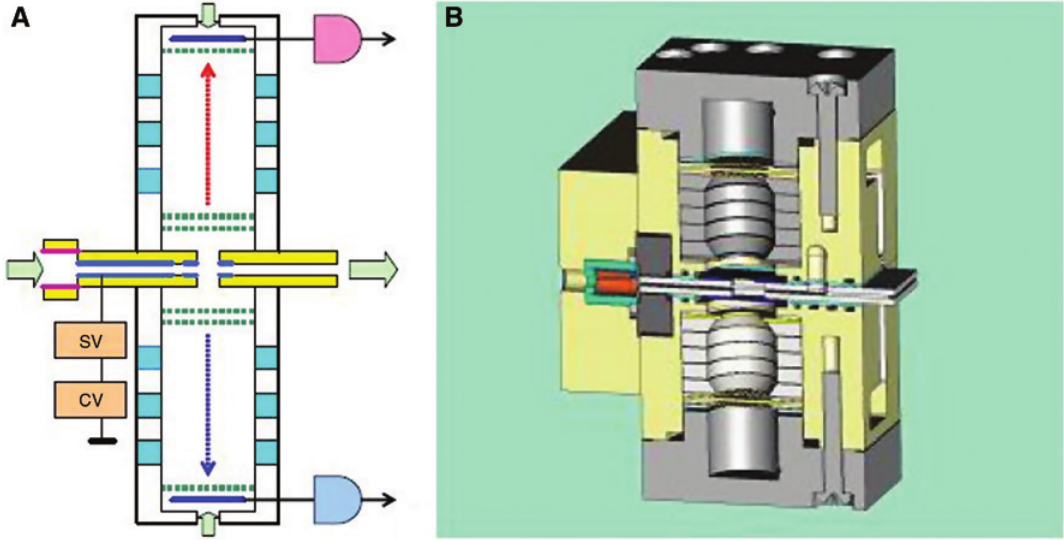
Figure 7: Schematic of DMS-IMS 2 .